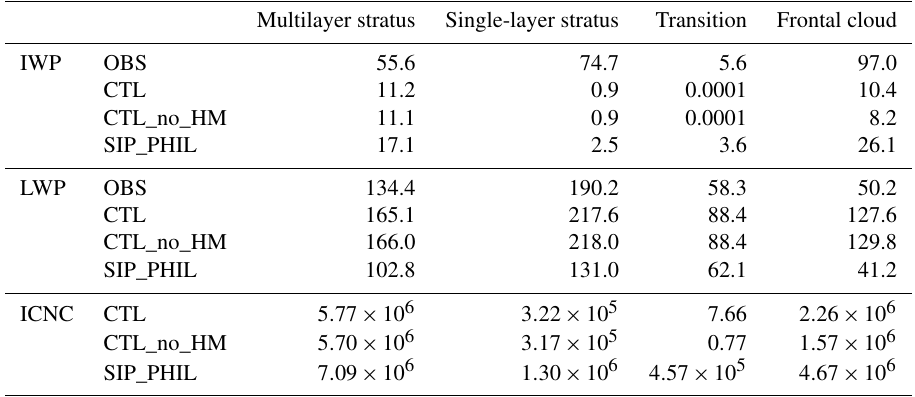
Table 2. The temporally averaged IWP, LWP (unit: gm − 2 ), and vertically integrated ice crystal number concentration (unit: m − 2 ) during the four periods from observations (OBS) and CTL, CTL_no_HM, and SIP_PHIL